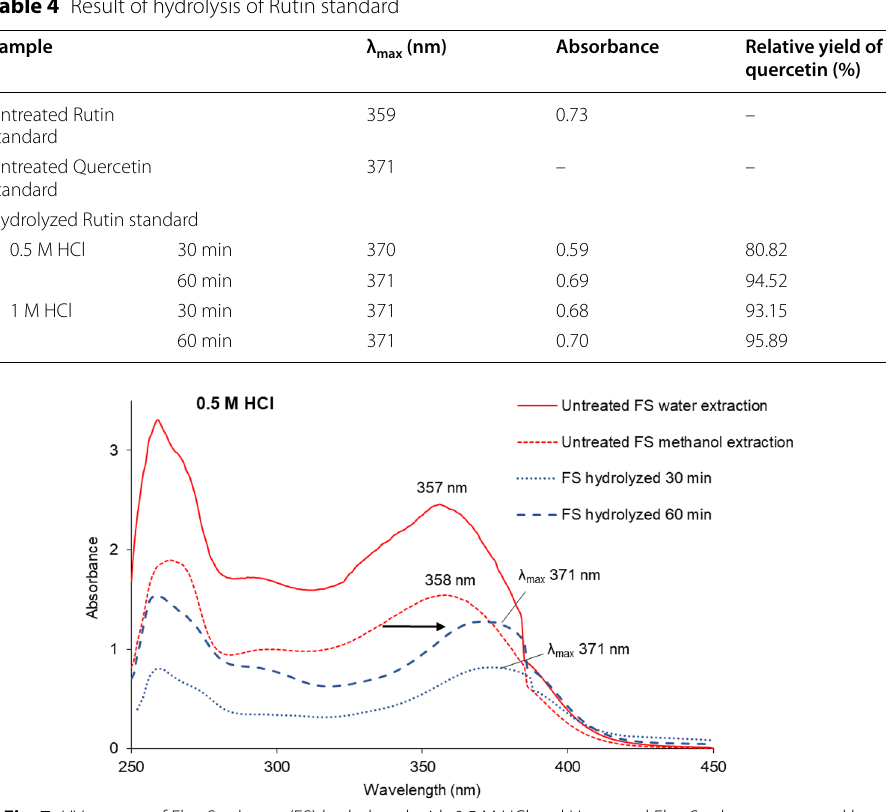
Fig. 7 UV spectra of Flos Sophorae (FS) hydrolyzed with 0.5 M HCl and Untreated Flos Sophorae extracted by water and